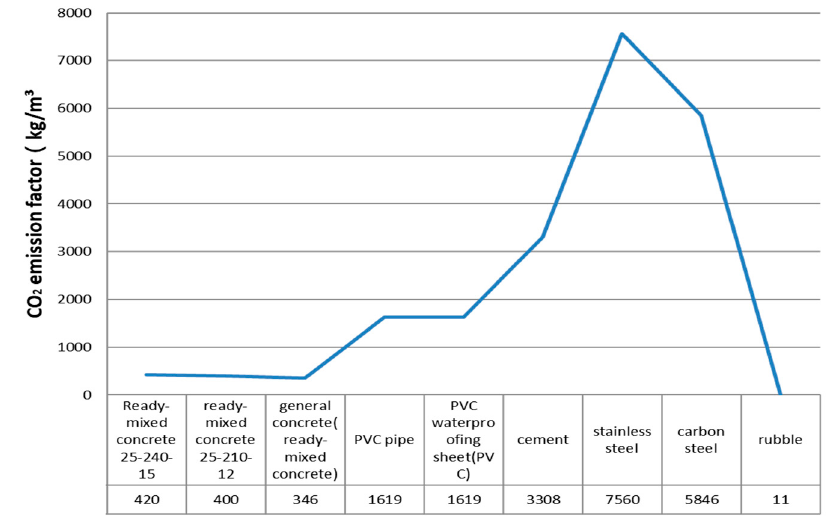
Figure 9. CO 2 emission factors of materials in tunnel.